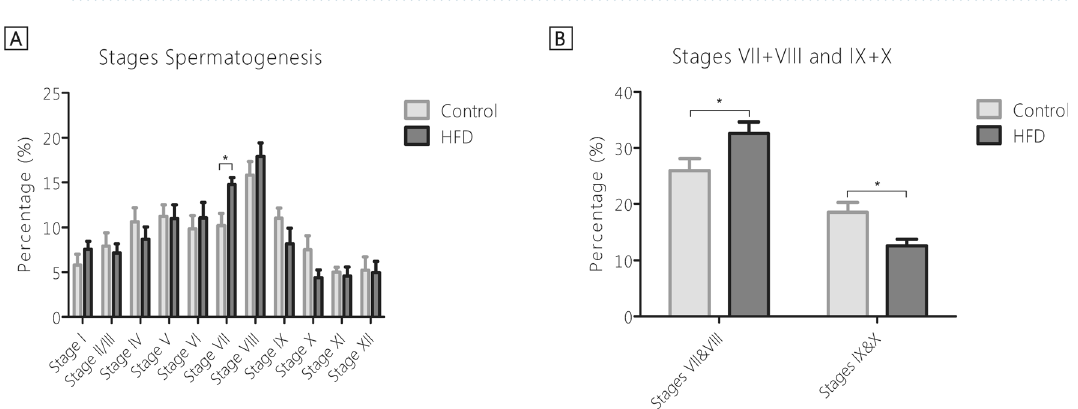
Figure 3. Stages of spermatogenesis in seminiferous tubules. ( A ) Analysis of the seminiferous stages, displayed as percentage of the total number of seminiferous tubules analysed. ( B ) Analysis of the stages VII & VIII and IX & X, displayed as percentage of the total number of seminiferous tubules analysed. Control n = 10. HFD n = 10. *p <